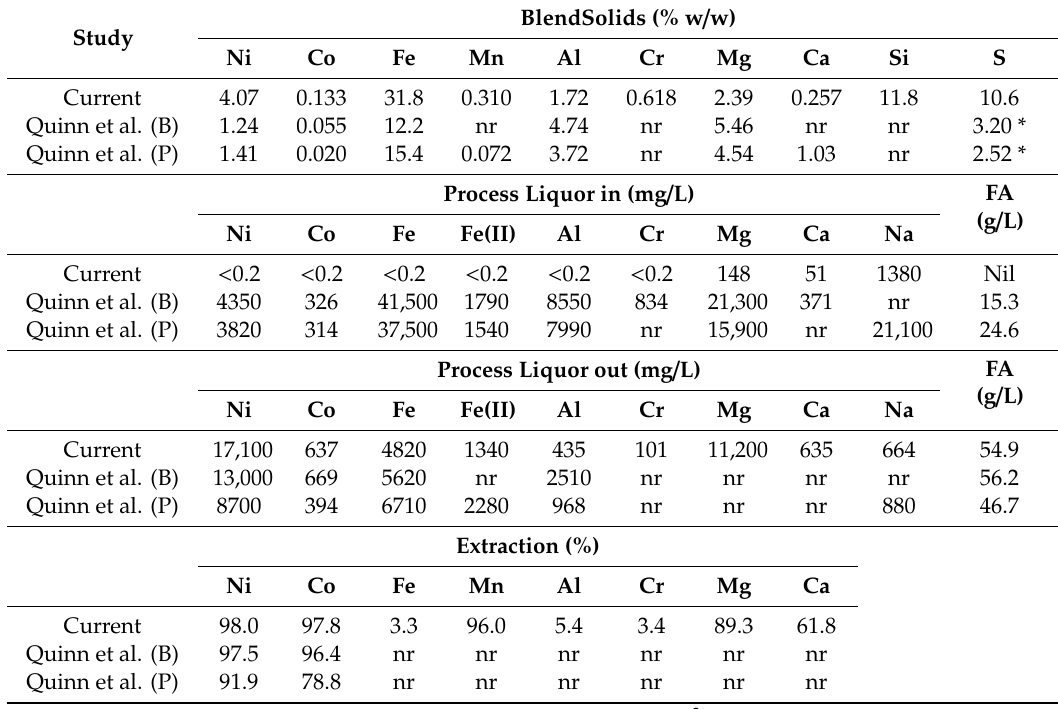
Table 3. Comparison of the feed blend composition (% w / w), process liquor compositions (mg / L), free acid (g / L), and extraction data between the current study and that of Quinn et al.